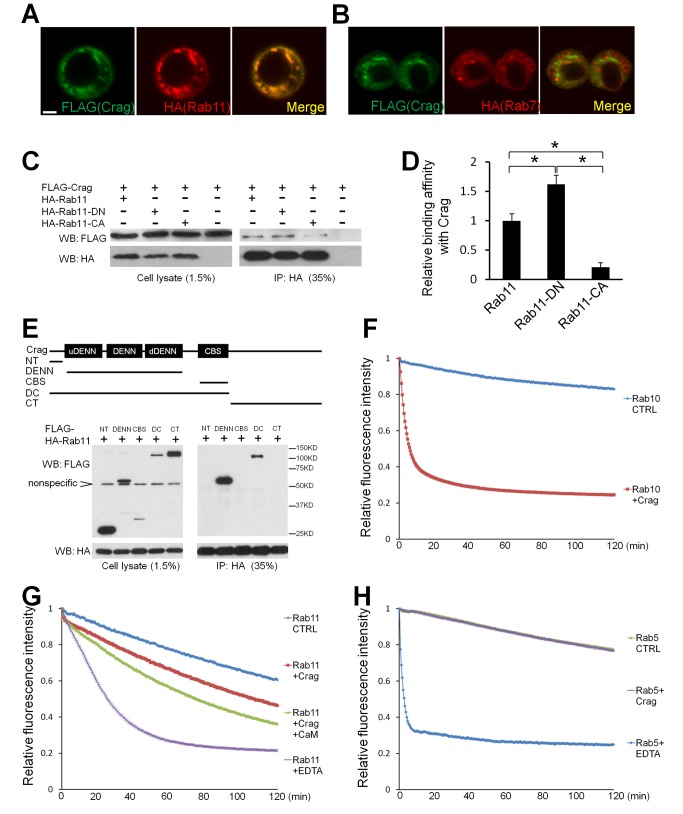
Crag interacts with Rab11 in vitro.(A) Immunostaining of S2 cells transfected with FLAG-tagged Crag (green) and HA-tagged Rab11 (red). Their expression regions largely overlap. Scale bar, 2 µM. (B) Immunostaining of S2 cells transfected with FLAG-tagged Crag and HA-tagged Rab7. No significant colocalization is observed. (C) S2 cells transfected with FLAG-tagged Crag and/or HA-tagged Rab11, Rab11-DN, or Rab11-CA were harvested and lysed. Anti-HA gel was used to pull down HA-tagged proteins. When Rab11 and Crag are co-transfected, Crag was also co-immunoprecipitated, as detected on Western blots, indicating that Crag binds to Rab11. Also note that Crag preferentially binds to the DN form of Rab11 rather than the CA form. (D) Quantification and statistics of binding affinity between Crag and the different forms of Rab11 shown in (A). The data are quantified using the Gel analysis function in Image J. Results from three independent experiments were analyzed. An asterisk indicates a p-value less than 0.05. (E) A scheme of different Crag deletion constructs and their binding affinity with Rab11 was tested by co-IPs. Crag segments containing DENN domains (DENN and DC) bind to Rab11, whereas the segments that lack DENN domains (NT, CBS, and CT) do not, indicating that the interaction between Crag and Rab11 is dependent on DENN domains. (F) GEF assay of Crag and Rab10. Crag and Rab10 proteins were purified using a baculovirus system. Rab10 was preloaded with fluorescence-labeled BODIPY-GDP, and then GTP was added with or without Crag. The change of fluorescence intensity was recorded for 2 h. Crag promotes the release of GDP from Rab10, indicating it possesses GEF activity against Rab10. (G) GEF assay of Crag and Rab11. Crag promotes GDP release from Rab11, and the presence of CaM and calcium further enhances the release rate. 10 mM EDTA was used as a positive control, as EDTA absorbs Mg2+ from Rab11 and triggers GDP release. (H) GEF assay of Crag and Rab5. No GEF activity against Rab5 was observed, whereas 10 mM EDTA triggers a rapid release of GDP from Rab5.